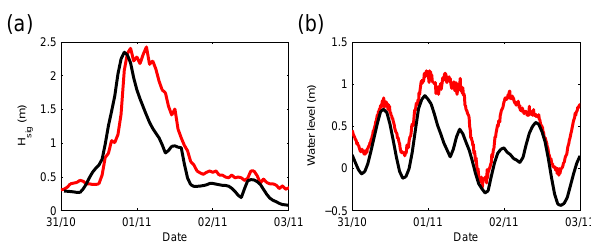
Figure 7. Co-located measured (red lines) and 3-day forecast (black lines) wave and water-level conditions for 31 October 2012. (a) Sig- nificant wave height. (b) Water level. Wave and water-level data are derived from the Cesenatico wave buoy and Ravenna tide gauge re-